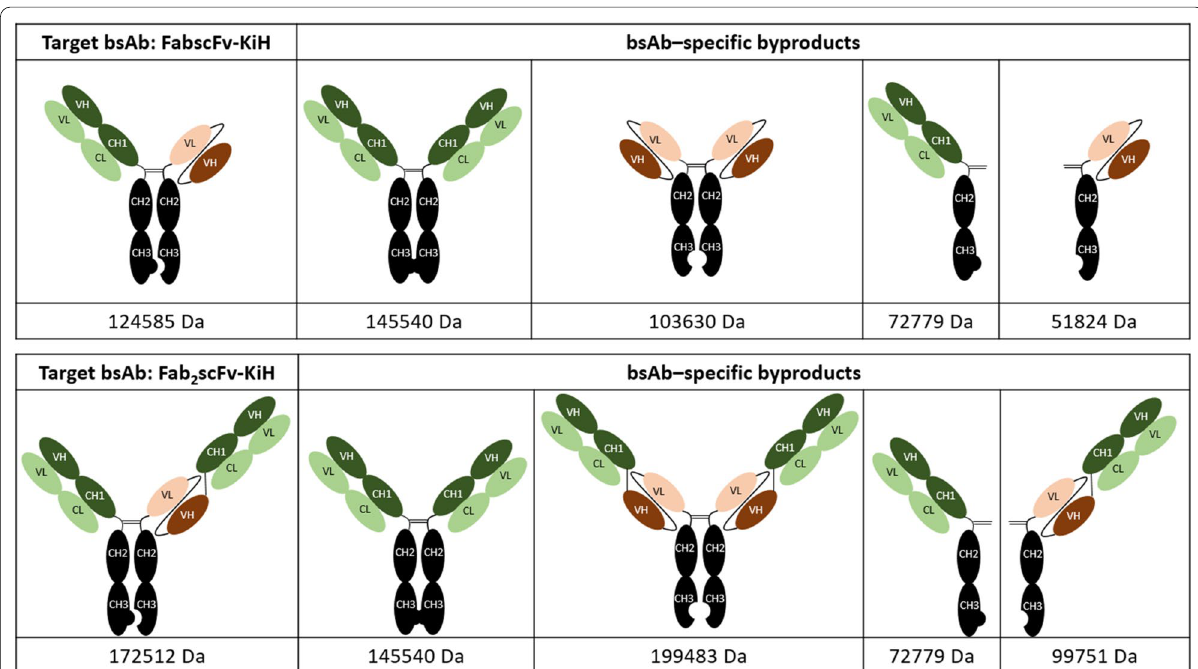
Fig. 1 Schematic representation of the model asymmetric bsAbs along with their possible major byproducts. FabscFv-KiH and Fab 2 scFv-KiH are the model asymmetric bsAbs used in this study, and their possible major byproducts include the mispaired homodimers and half-antibodies. The corresponding molecular weight indicated below each species was calculated based on its respective protein